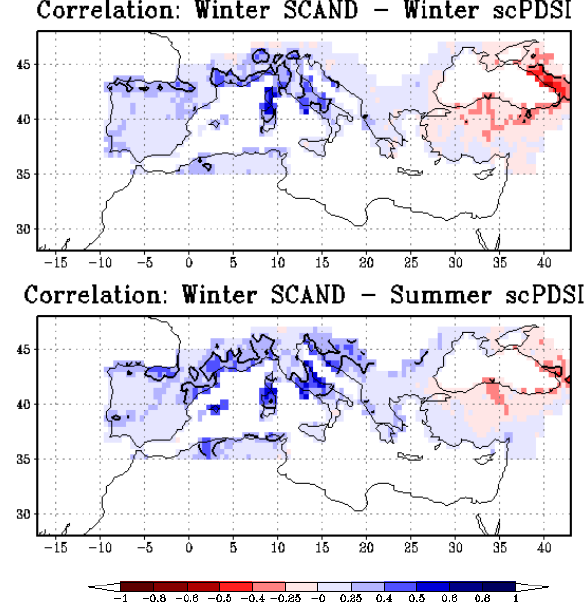
Fig. 10. Correlation between the winter NAO and the winter scPDSI (top) and the following summer scPDSI (bottom) during the 1951– 2000 period – circled areas are statistically significant at 10%.